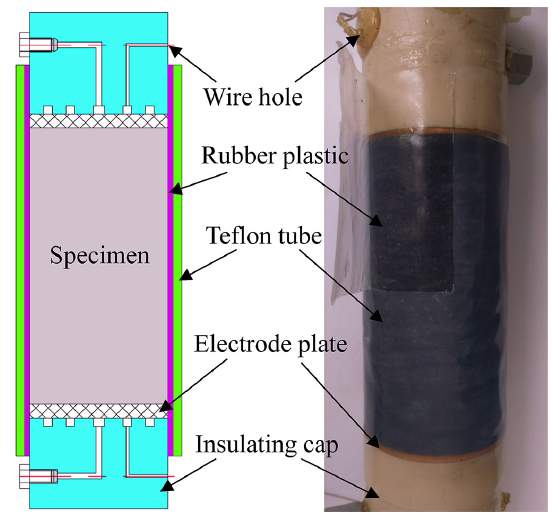
Figure 6. Sealed specimen.